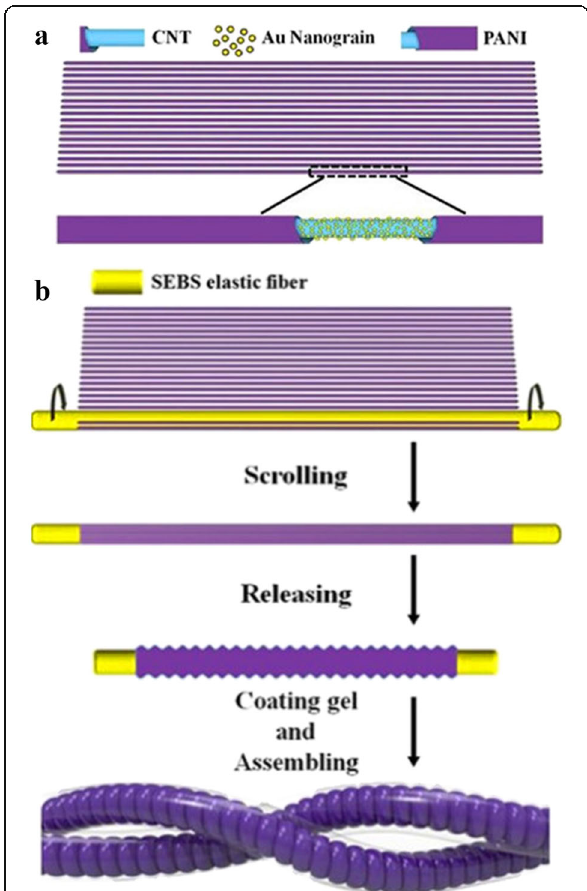
Fig. 1 a , b Fabrication process of the stretchable linear supercapacitors